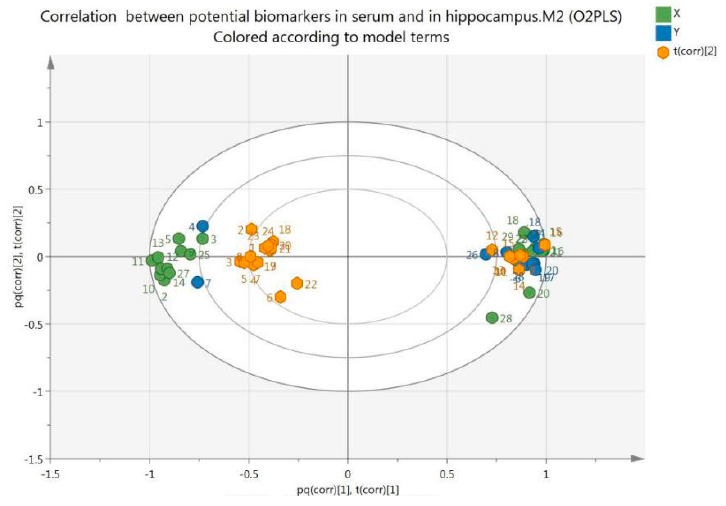
Figure 9. The predictive ROC curves generated using 29 biomarkers contributing to MDD progress and PF treatment. ( A ) C M > C N ; ( B ) C M < C N ; ( C ) C M > C HPF ; ( D ) C M < C HPF . The numbers are consistent with the No. in Table 1.